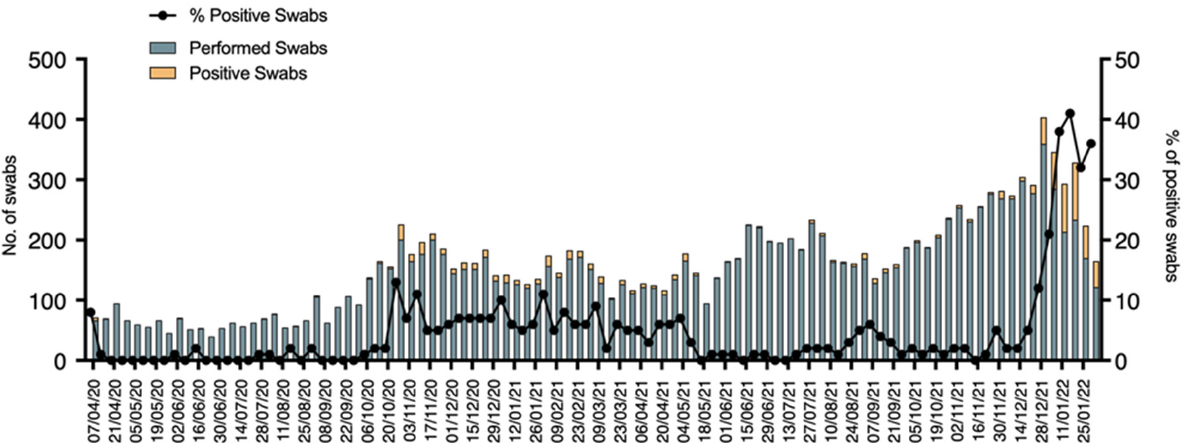
Figure 3. Black dots represent the percentage of positive swabs compared to the performed ones. Green columns represent the median number of daily performed swabs for each week. Yellow columns represent the median number of positive swabs for each week.